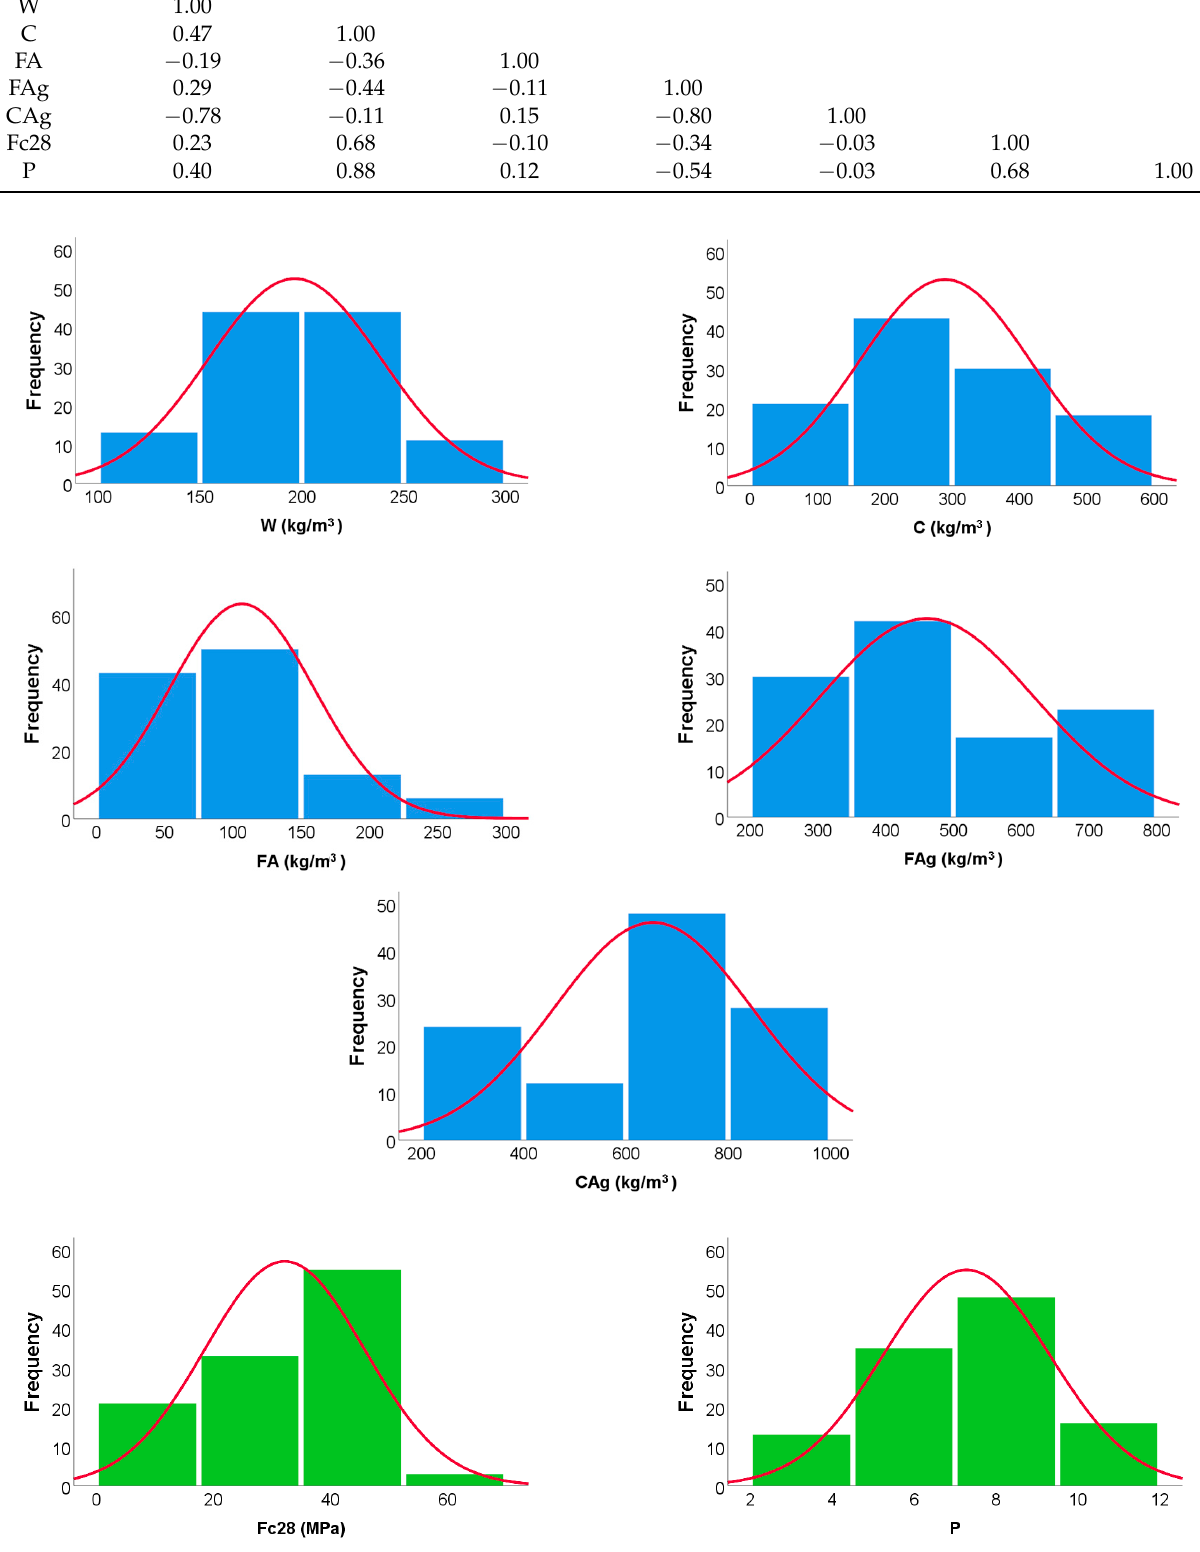
Figure 2. Distribution histograms for inputs (in blue) and outputs (in